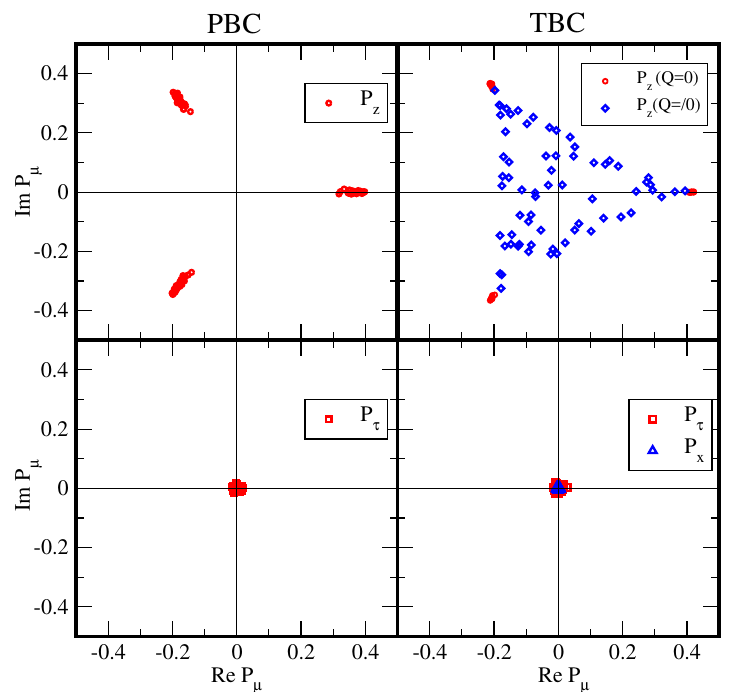
Figure 7 . Scatter plot of the Polyakov loop for each direction. Top-left and bottom-left panels show the spatial and the temporal Polyakov loops on the PBC lattice, respectively. Top-right panel shows the results of P z , while the bottom-right panel gives the ones of P x (blue-triangle) and P (cid:28) (red-square) on the TBC